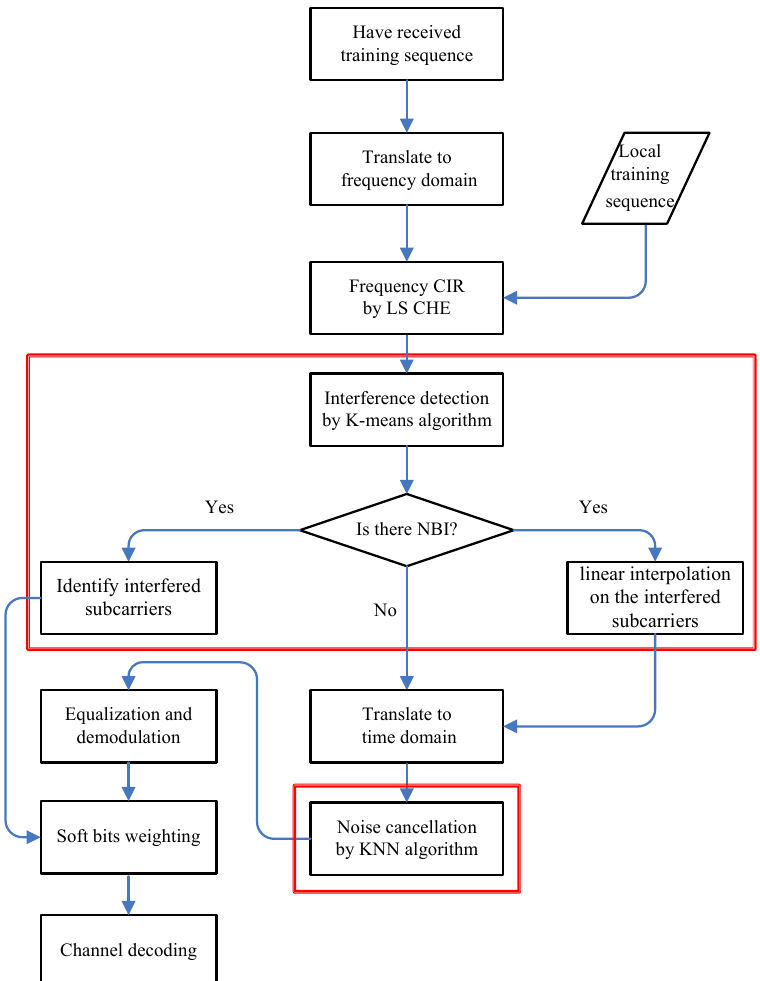
Figure 2. The integrated process of channel estimation with interference